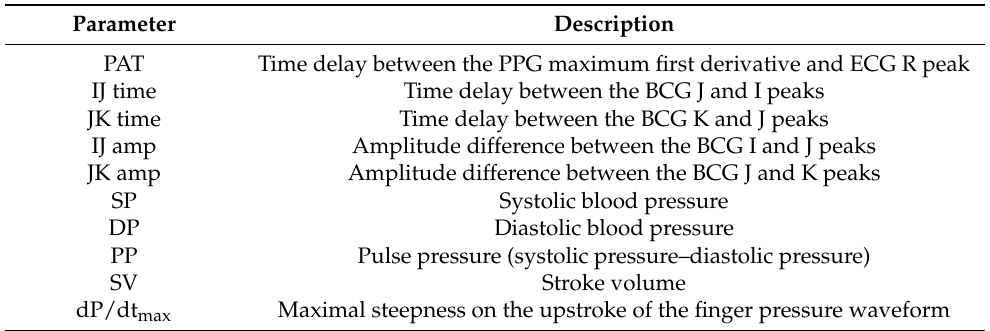
Table 2. Beat-to-beat electrocardiogram (ECG), photoplethysmogram (PPG), ballistocardiogram (BCG), and cardiovascular parameters.